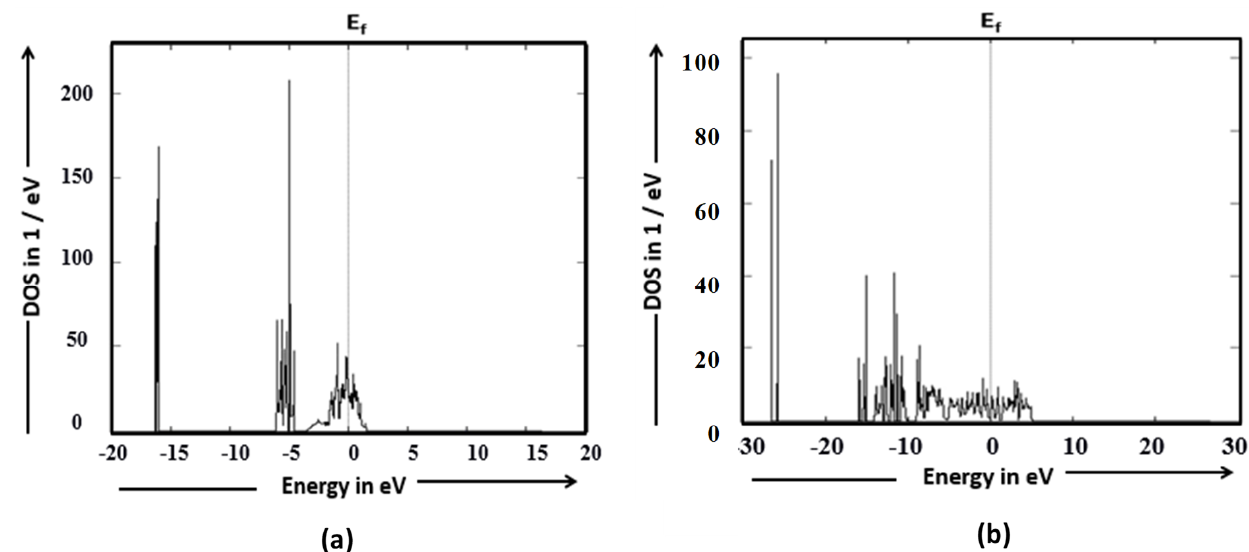
Figure 3. The density of states (DOSs) for ( a ) Nb 2 N and ( b ) Nb 4 N 3 .